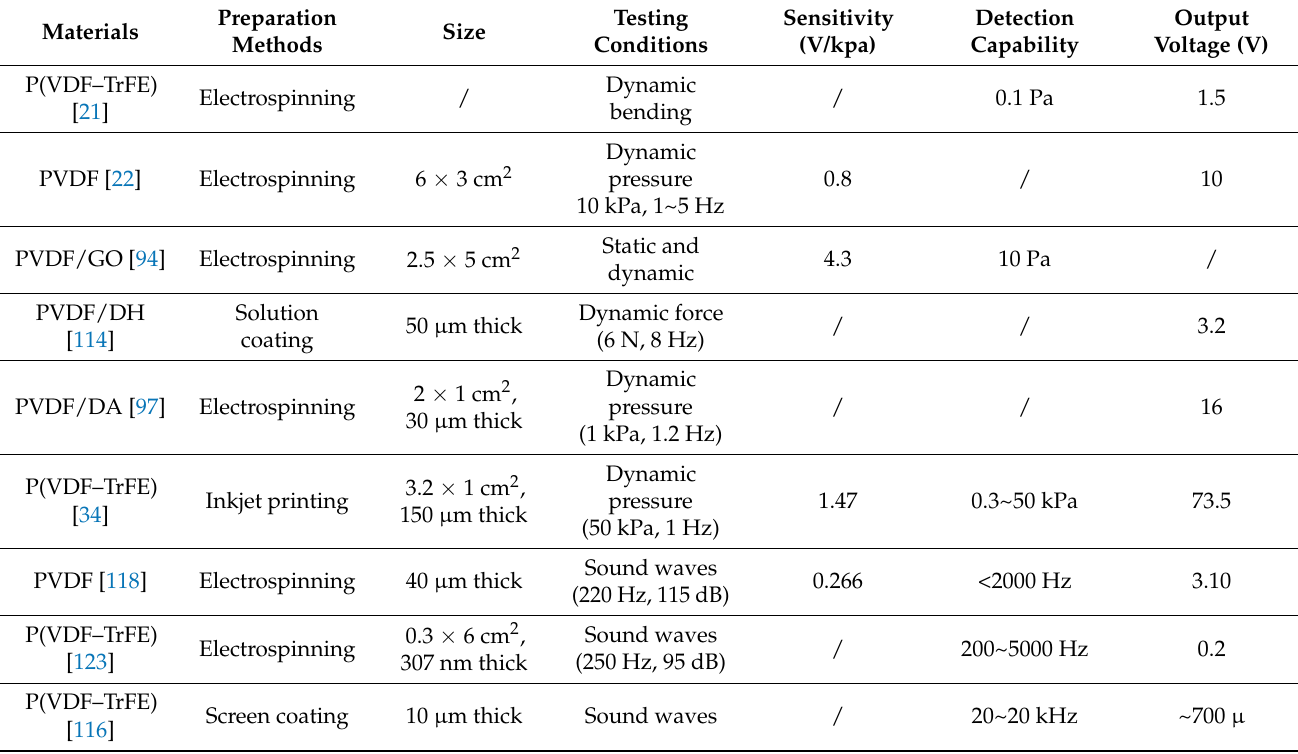
Table 3. Performances of several kinds of PVDF-based piezoelectric